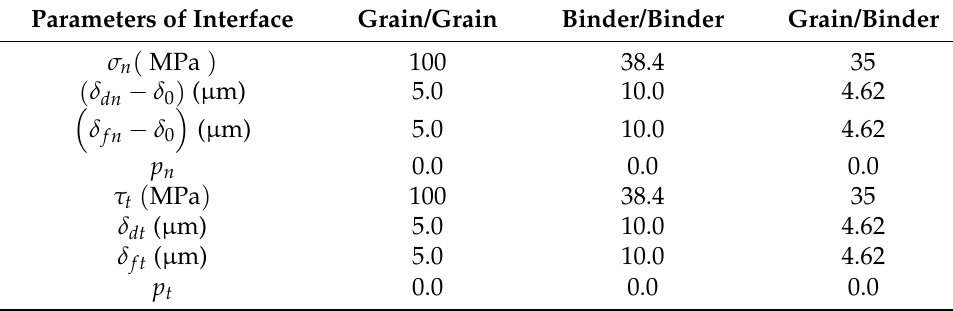
Table 2. Parameters of interface property